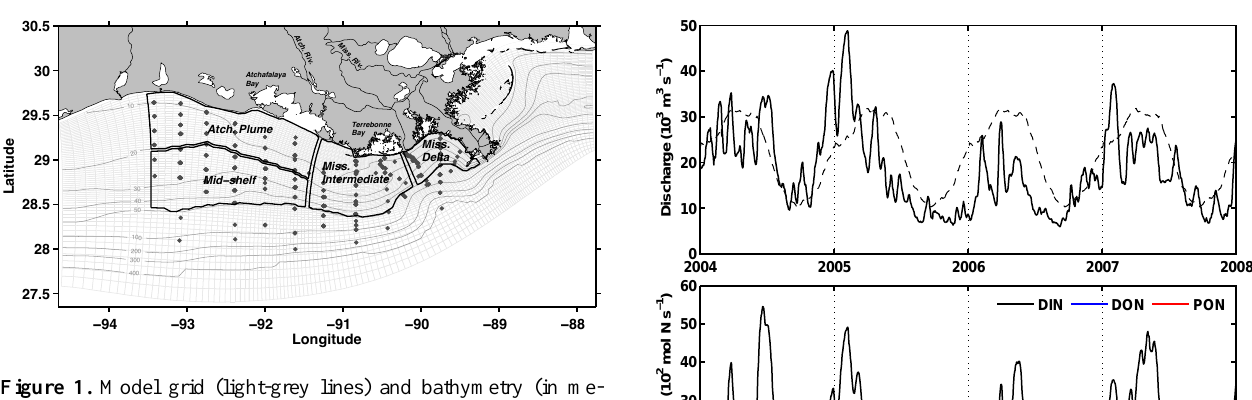
Figure 1. Model grid (light-grey lines) and bathymetry (in me- ters). The black lines delineate areas used during model analysis and are referred to as Mississippi Delta, Mississippi Intermediate, Atchafalaya Plume, and Mid-shelf region in the text. The black dots are stations where primary production (Lehrter et al., 2009) and res- piration rates (Murrell et al., 2013) were collected.